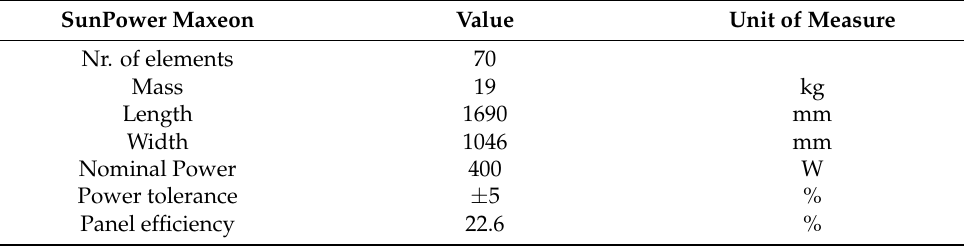
Table 8. Photovoltaic panel “SunPower Maxeon”